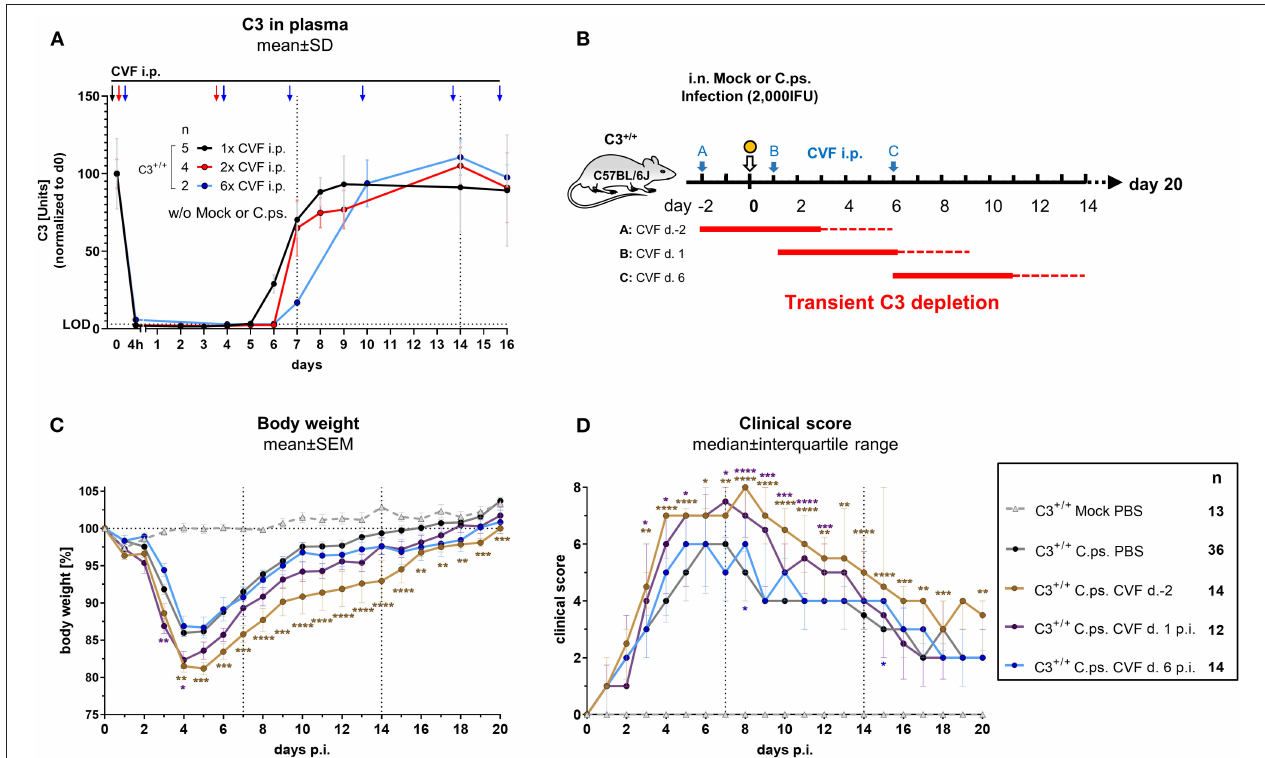
FIGURE 2 | Presence of C3 during the first days of C. psittaci lung infection is required to provide optimal protection. Healthy, non-infected C3 + / + mice were treated 1, 2, or 6 times i.p. with Cobra venom factor (CVF) as indicated by the black, red, or blue arrows, respectively. EDTA plasma from these mice was collected at the indicated time-points, and C3 levels were determined by ELISA. Pooled plasma from WT mice served as standard defining 100U (A) . To assess the relevance of complement at different phases of C.ps. infection, C3 was transiently depleted by single application of CVF 2 days before, or on day 1 or 6 after C.ps. (2,000 IFU) infection. In this scheme, the blue arrows indicate the different time-point of CVF application, red horizontal lines represent the expected resulting periods of decomplementation (B) . Infected and mock-infected control mice were treated with PBS instead of CVF (dark circles and light gray rectangle in C,D ). Body weight (C) and clinical score (D) were assessed daily. The results of Mock-infected C3 + / + mice receiving PBS instead of CVF are also depicted in these graphs. Of all mice, only 2 of 12 on day 2 pre-infection CVF-treated mice reached the humane endpoint prematurely (data not shown). The results depicted in (A,C,D) were combined from four, independent experiments. Statistical analysis was performed by Two-way ANOVA ( A,C ), repeated measurements with mixed effects model followed by Bonferroni post-test, or by Kruskal-Wallis test followed by Dunn’s multiple comparison post-test (D) . Statistical significance according to the calculated p -value: * p ≤ 0.0332; ** p ≤ 0.0021; *** p ≤ 0.0002; **** p ≤ 0.0001. Illustrations were partially created using templates from www.motifolio.com. d., day; LOD, limit of